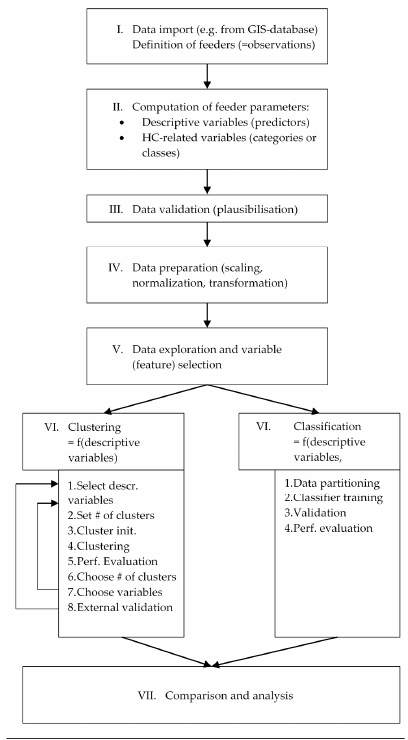
Figure 1. General concept used to perform the clustering and classification.